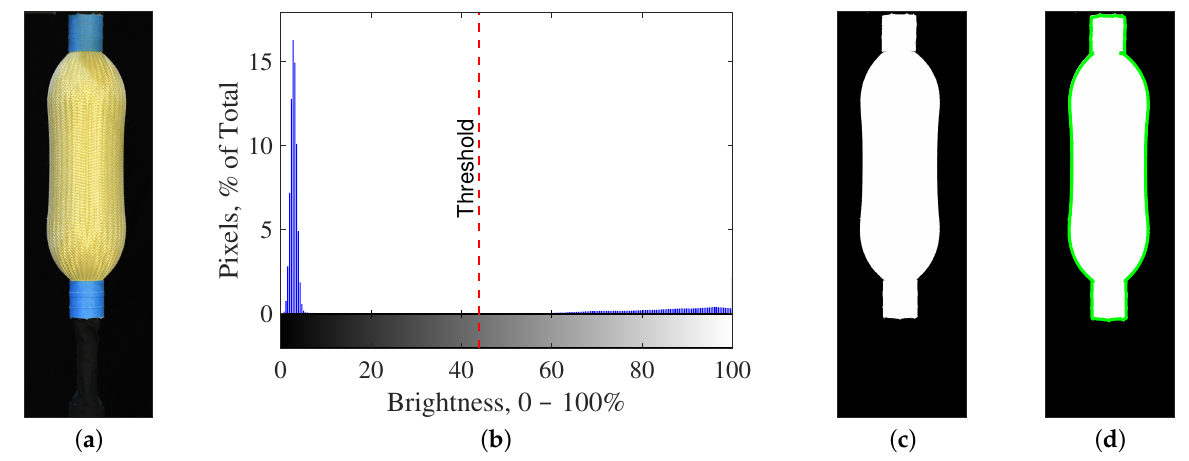
Figure 9. Identification of the PAM in the image: ( a ) Initial image. ( b ) Step 1a: Pixel segmentation histogram using Otsu’s method to set threshold on brightness ( V ). ( c ) Step 1b: V segmented binary image. ( d ) Step 2: Traced outline of PAM.